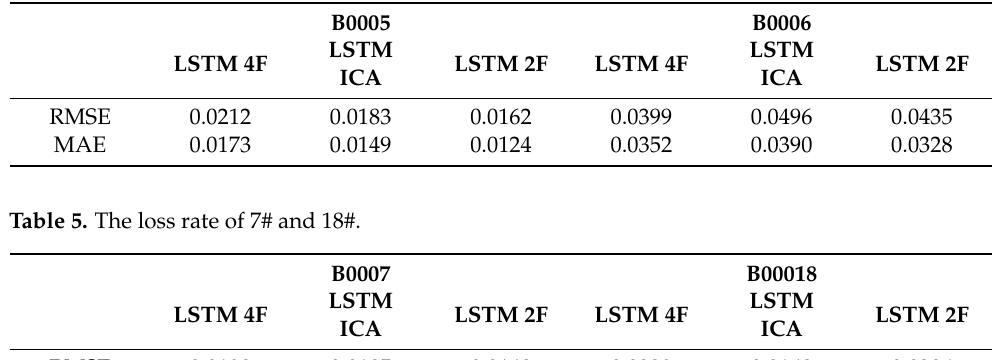
Table 4. The loss rate of 5# and 6#.